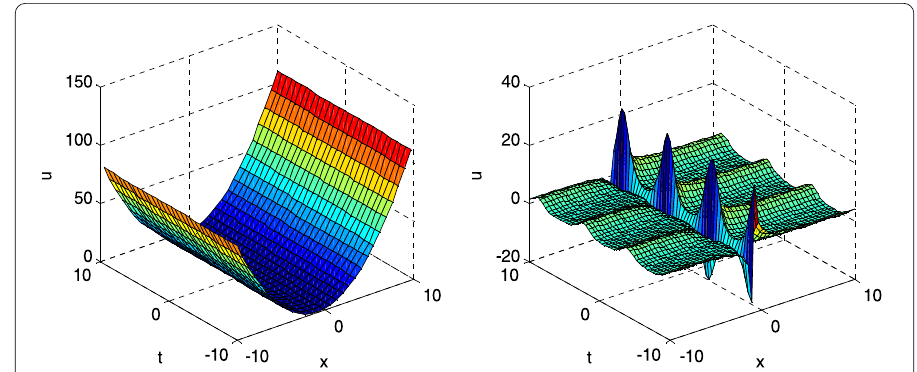
Figure 2 Smooth soliton solution (left) and breather soliton solution (right) given by equation (3.26) with K 3 = –1, A = B = 1, a 2 = c 0 = λ 4 = 1, and τ 1 ( t ) = cos( t ) + sin( t